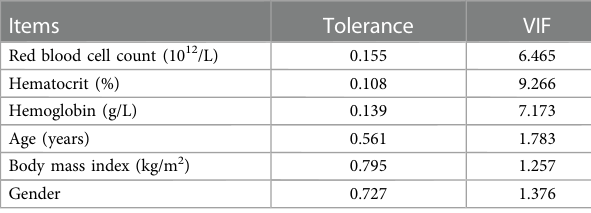
TABLE 2 The multicollinearity analysis.